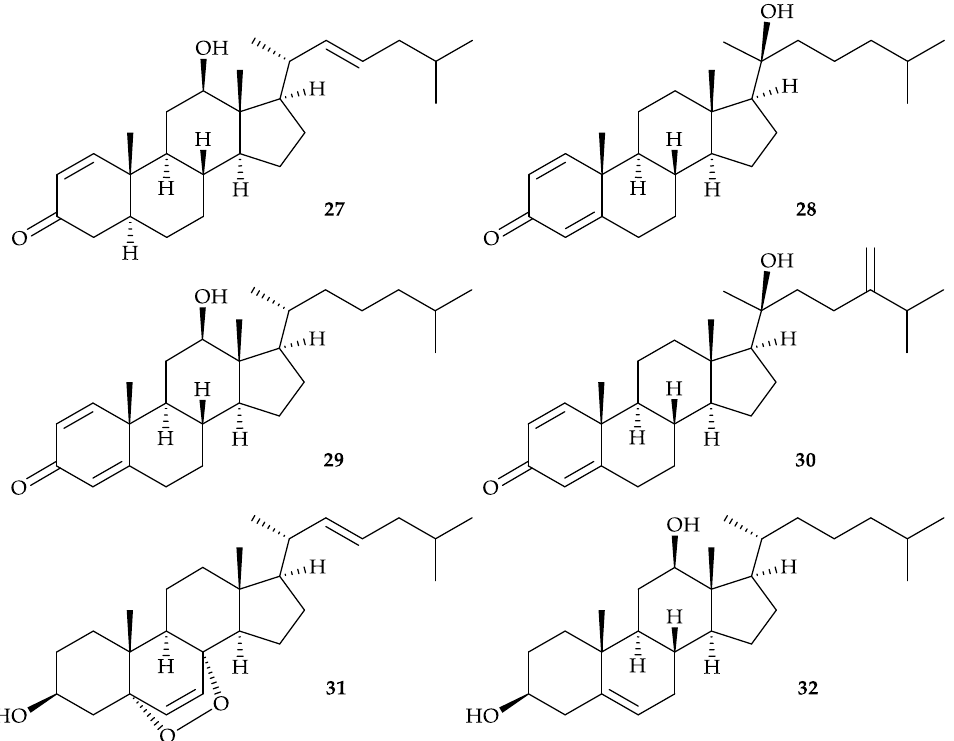
Figure 6. Structures of 3-oxocholest-1,22-dien-12β-ol ( 27 ) 3-oxocholest-1,4-dien-20β-ol ( 28 ), 3-oxo- Figure 6. cholest-1,4-dien-12β-ol ( 29 ), (20 S )-20-hydroxyergosta-1,4,24-trien-3-one ( 30 ), 5α,8α-epidioxy- cholesta-6,22-dien-3β-ol ( 31 ), and 5-cholestene-3β,12β-diol ( 32 ).